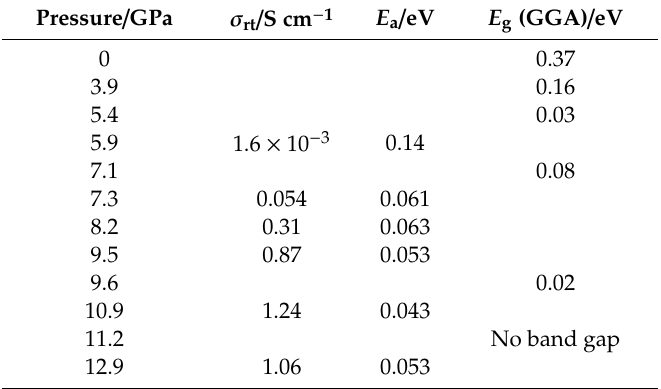
Table 1. Room temperature conductivity, σ rt , and activation energy, E a , determined by experimental resistivity measurements, and the density functional theory (DFT) electronic band gap at the Γ point, E g , calculated using the GGA-PBE functional at various